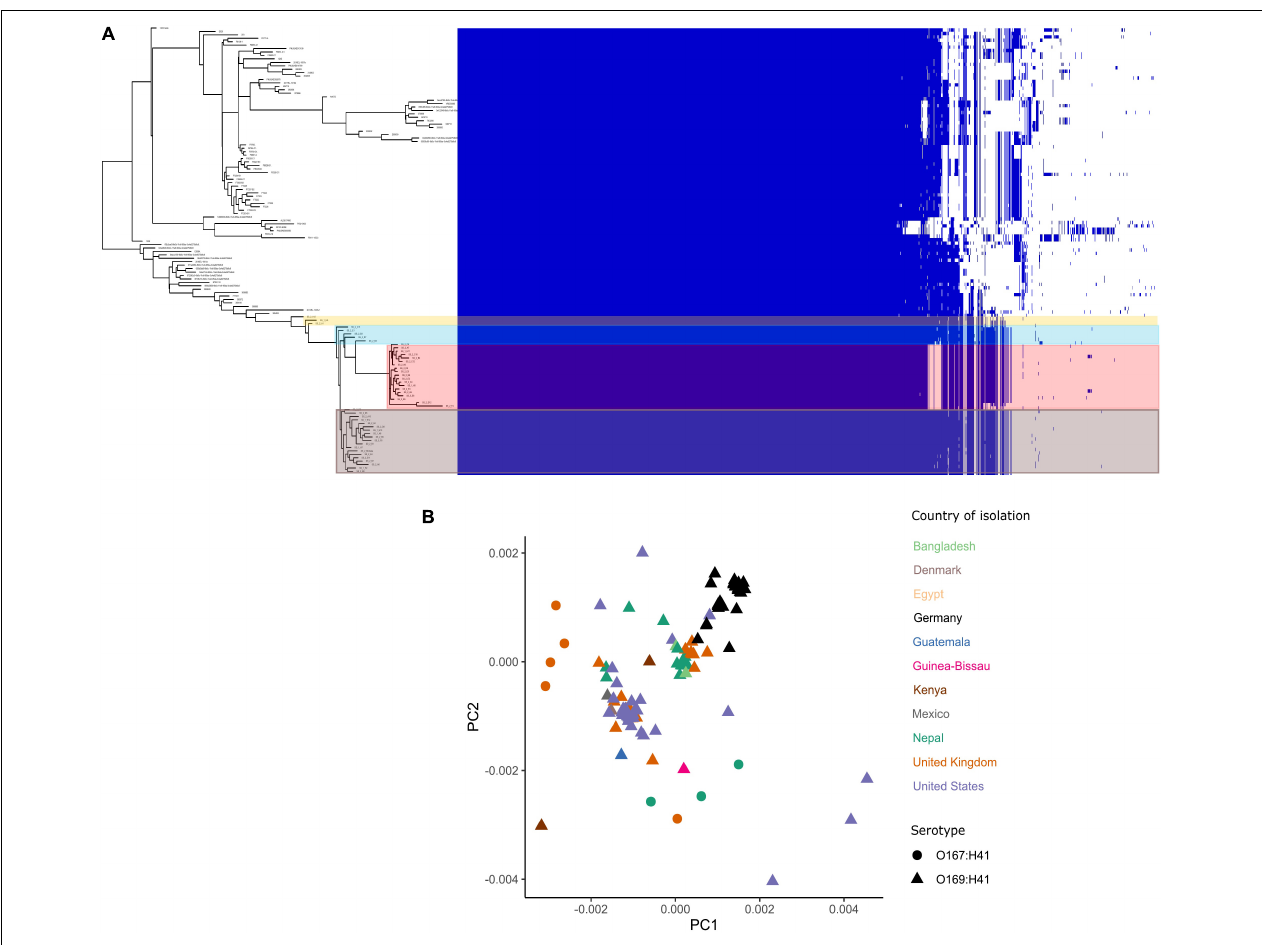
FIGURE 2 | E. coli ST182 pangenome. (A) Gene presence/absence matrix clustered by accessory genome visualised using Phandango. Airplane waste isolate clusters highlighted. (B) MDS illustrating pairwise genome distances calculated using Mash. Isolates colored by country of isolation. All originating from Germany (black) pertain to this collection. Shapes distinguish